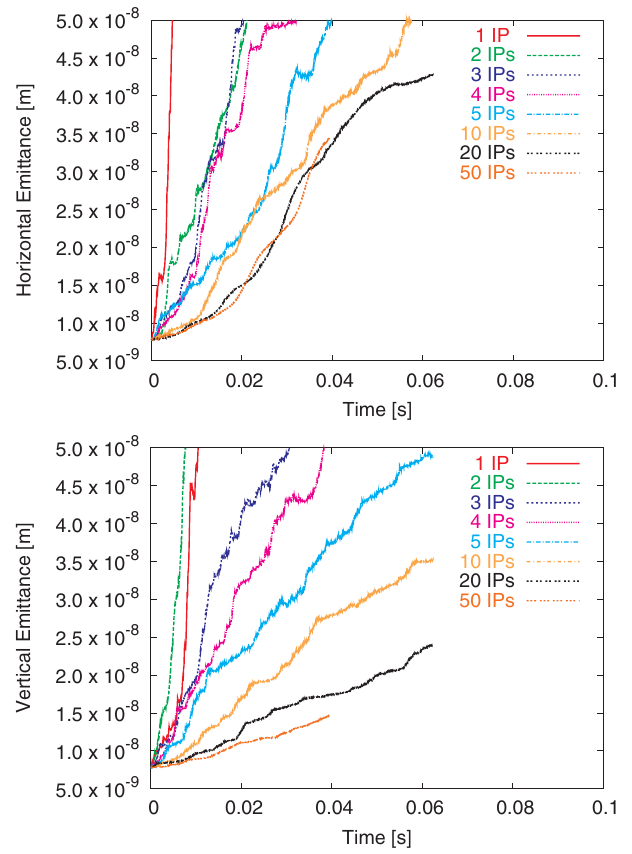
FIG. 6. (Color) Emittance growth for a turn-by-turn random phase advance between IPs; horizontal (top) and vertical (bot- tom) emittance as a function of time with different numbers of IPs, for LHC at injection and an electron density of (cid:2) (cid:2) 6 (cid:6) 10 11 m (cid:4) 3